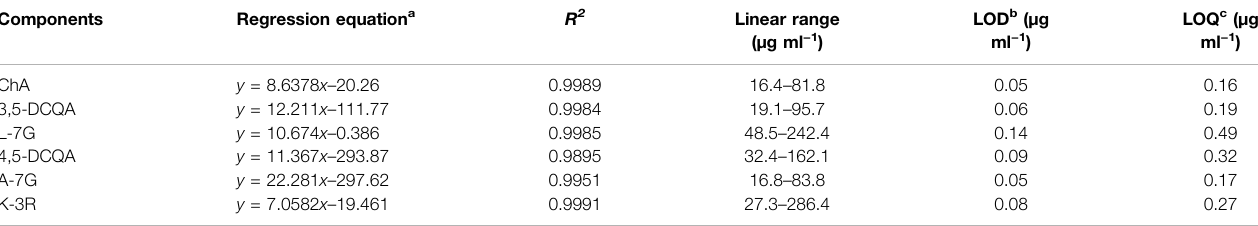
TABLE 4 | Linear relationship of standard substances from components of CMs. Components Regression equation